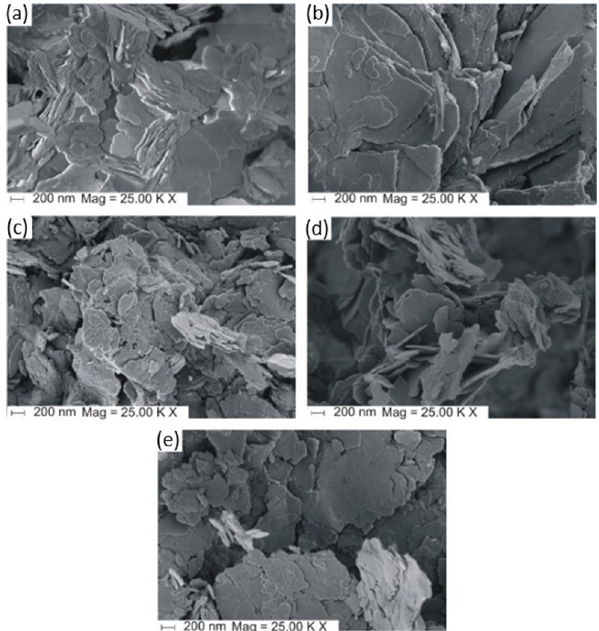
Figure 3. SEM images of ( a ) MgO-473; ( b ) MgO-573; ( c ) MgO-673; ( d ) MgO-873 and ( e ) MgO-1873.